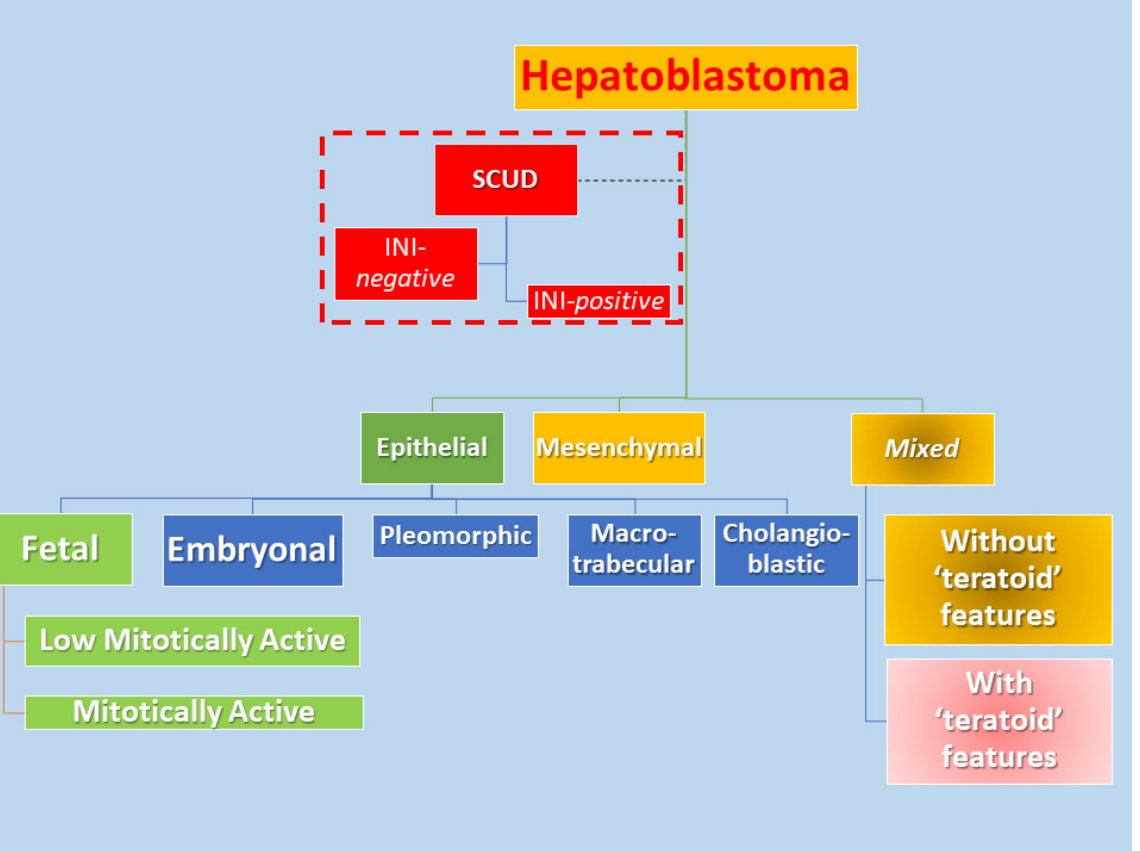
Figure 1. The schema depicts the most current classification of the subgroups of hepatoblastoma. The teratoid hepatoblastoma or hepatoblastoma with teratoid features is part of the mixed type (epithelial and mesenchymal components) of